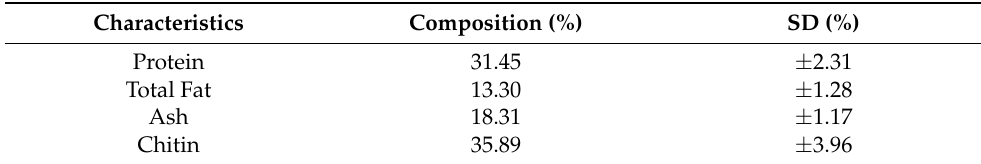
Table 1. Characterization of the initial waste (crustacean exoskeletons).